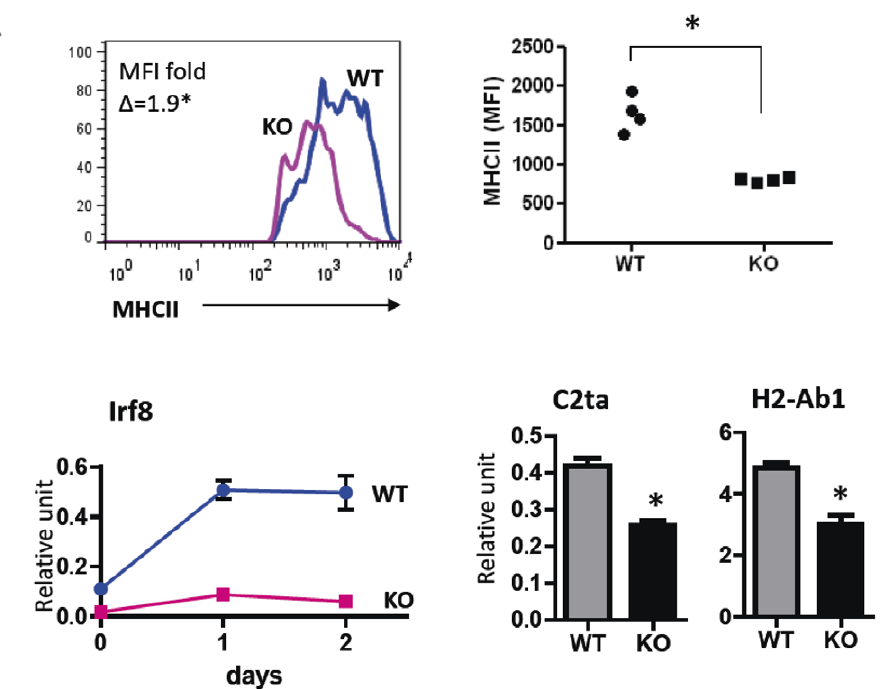
Figure 6. MHC II expression in germinal center B cells of IRF8 knock out mice. (A) MHC class II expression in GC B cells in IRF8 KO and WT mice. Representative histogram for MHC class II expression in GC B cells (left panel). Dot plot shows significant difference in MHCII expression between two groups. *, p , 0.05 from Mann-Whitney test. (B) MHC class II expression in in vitro stimulated B cells. Purified B cells were stimulated with IFN c for 2days. Transcript level of Irf8 were determined by qPCR at days 1 and 2 after stimulation (left panel). Transcript levels of C2ta and H2-Ab1 in wt and KO B cells determined by qPCR are shown (right panel). Data from four different mice in each group were examined by t-test. *, p , 0.05.